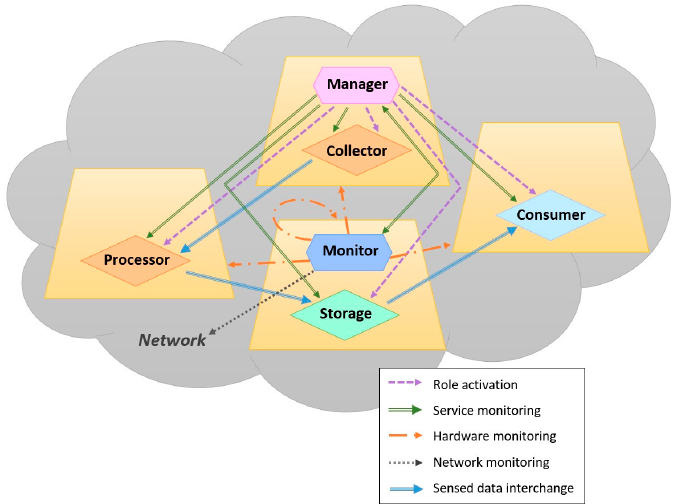
Figure 4. Interactions between MASU roles.